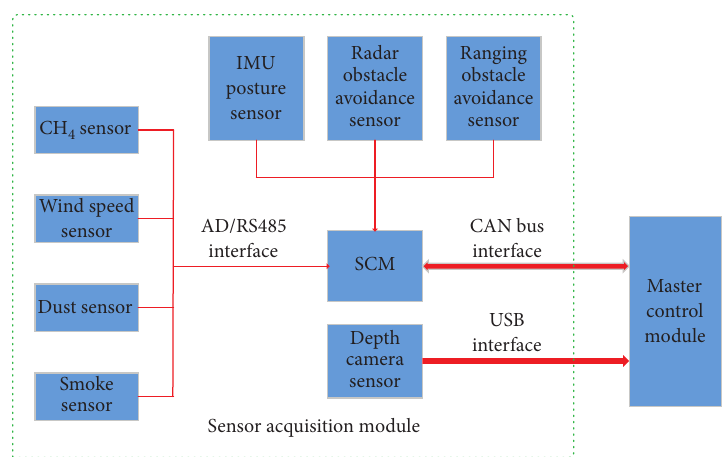
Figure 12: Structure of sensor acquisition